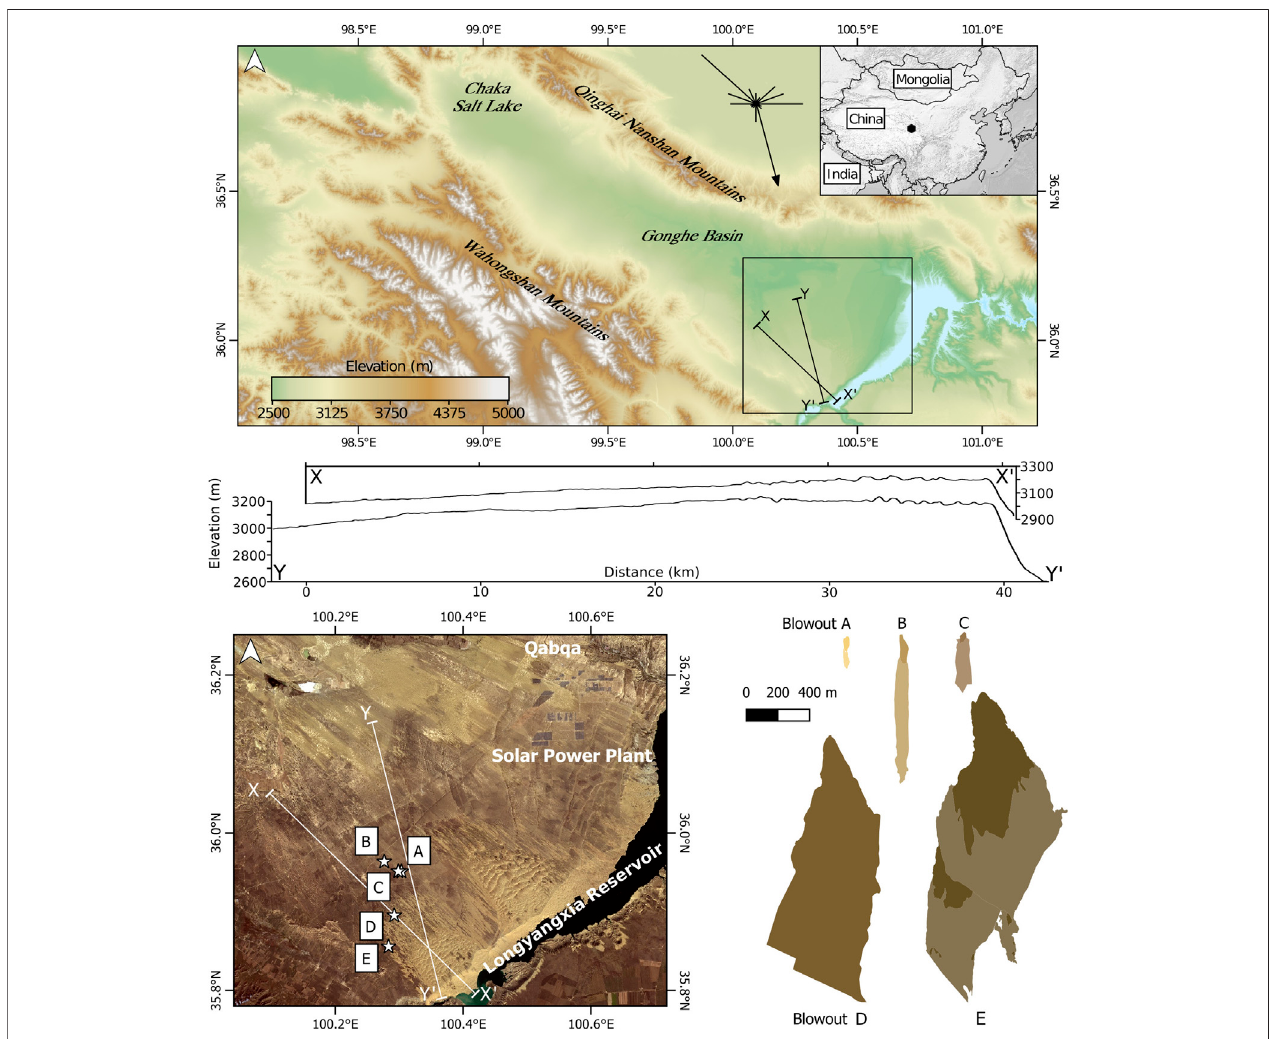
FIGURE 1 | The geographic setting, location, and relative scale of the studied blowout features in Gonghe Basin, Qinghai-Tibet Plateau, China. The presence of upwindblowoutsanddownwindmobilesanddunesshowsclearevidenceofdunereactivation.Topographicpro fi leX – X ′ isparalleltothedirectionofnetsandtransport, which is perpendicular to the orientation of the transverse dune fi eld at the highest point of the plateau. Topographic pro fi le Y – Y ′ is parallel to the average wind direction (wind rose from Zhang et al., 2003).